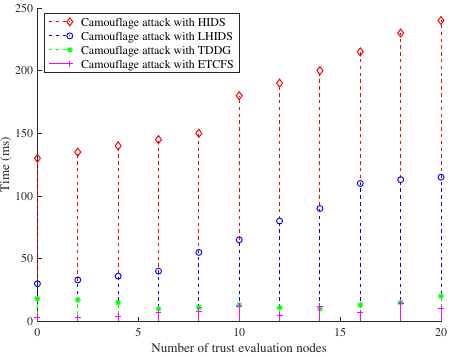
Figure 5. The time consumption with cluster formulation under different schemes in camouflage attack (hop limit = 1).